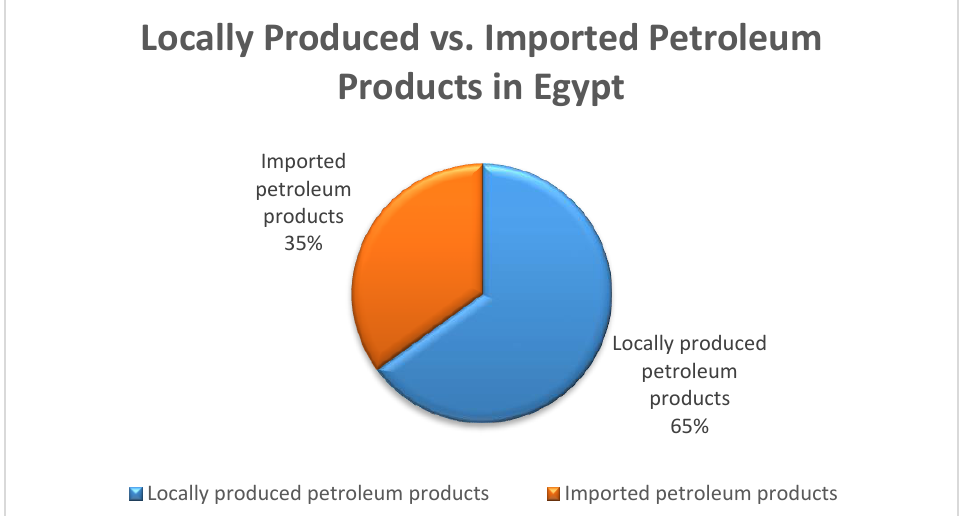
Figure 1. Local production and imports of petroleum products in Egypt.